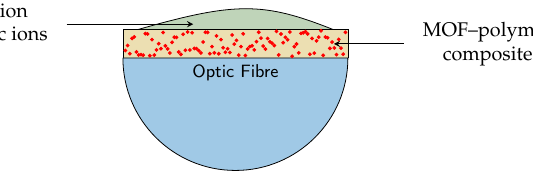
Figure 1. Two-dimensional cross-section of optic fibre with MOF–polymer thin film. Red dots represent MOF crystals in yellow polymer composite. Green represents solution being